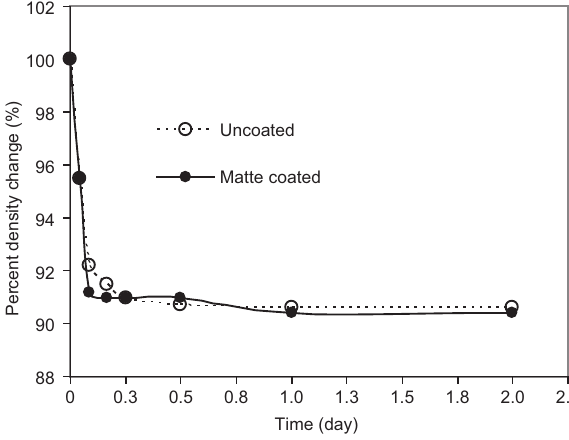
Table 2 ATR peaks taken from surfaces of uncoated and coated papers. Figure 3 Changes in print density of printed papers over time.